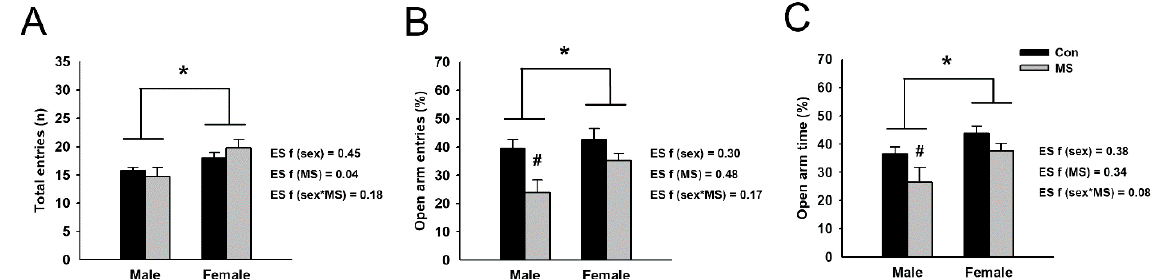
Figure 1. Anxiety-like behavior in maternal separation (MS) rats. Anxiety-like behavior was examined using the elevated plus-maze (EPM) test. ( A ) The number of total entries was assessed in control and MS rats. Anxiety-related behavior is indicated by the frequencies of open arm entries ( B ) and time spent in the open arms ( C ). Data are expressed as mean ± SEM. A two-way ANOVA test, * p < 0.05 on male vs. female; # p < 0.05 on control vs. MS within each sex. Effect size (ES) f was calculated using G*Power 3. n = 10–12 per group.